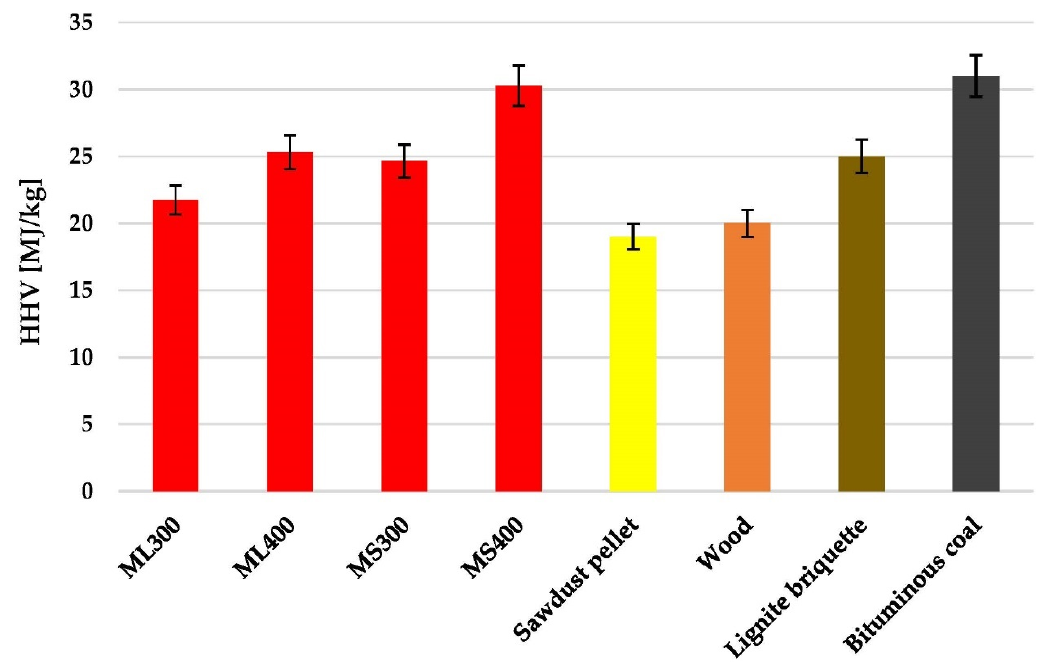
Figure 7. Comparison of the higher heating values of biochars prepared from mugwort post-extraction residue with commercial fuels. Table 7. Heats of combustion of various